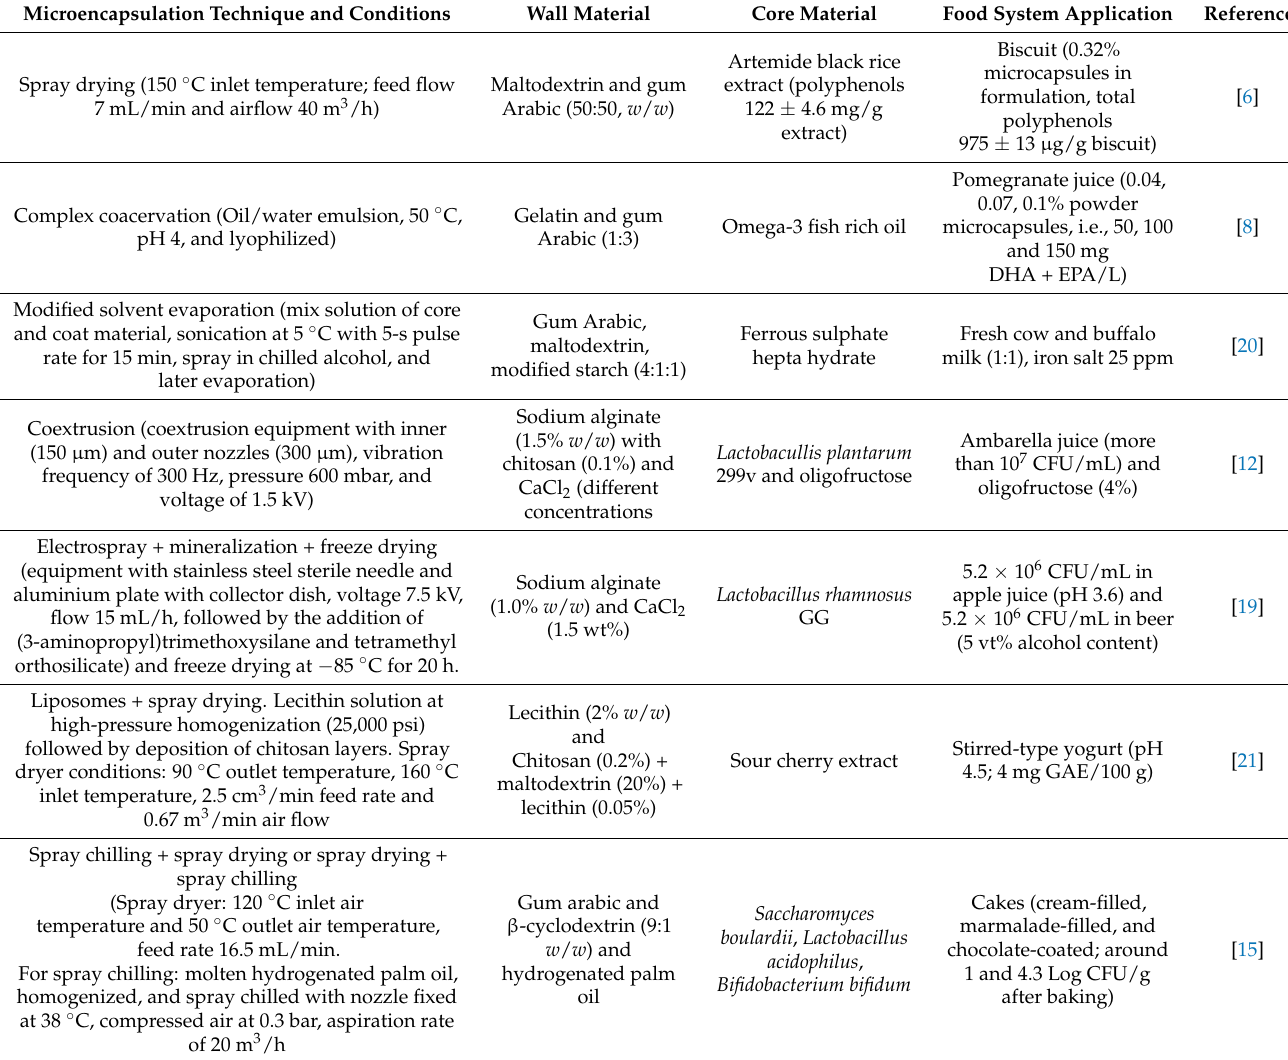
Table 2. Examples of microencapsulation techniques and their application in food.